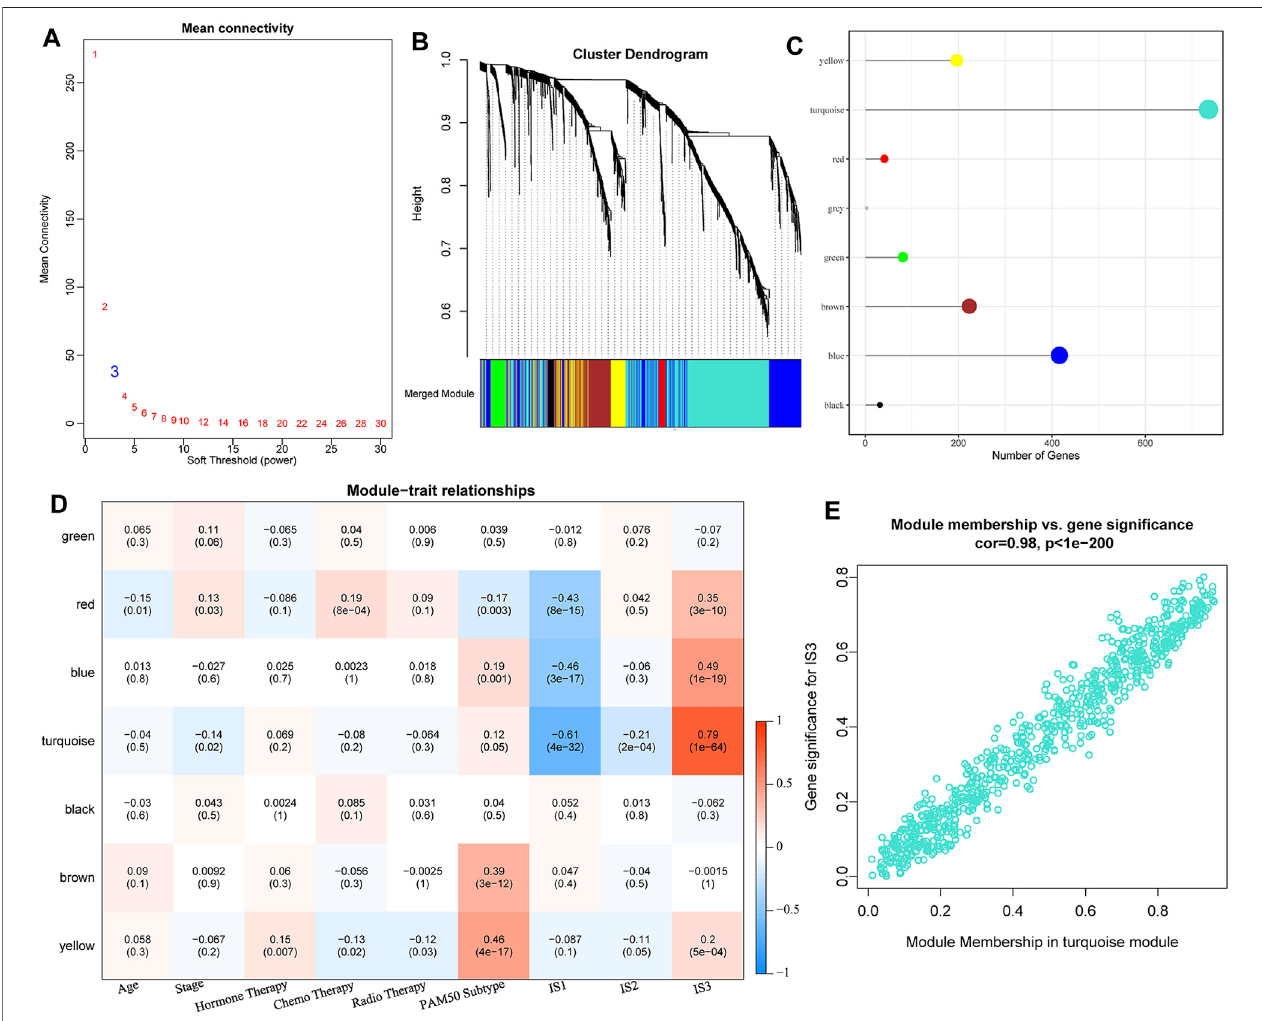
FIGURE 7 | (A) Analysis of network topology for various soft-thresholding powers. (B) Gene dendrogram and module colors. (C) Distribution of gene numbers in sevenmodules. (D) Heatmapofthecorrelationsbetweensevenmodulesandthreesubtypes. (E) Scatterdiagramofmodulemembershipvs.genesigni fi canceforIS3in the turquoise